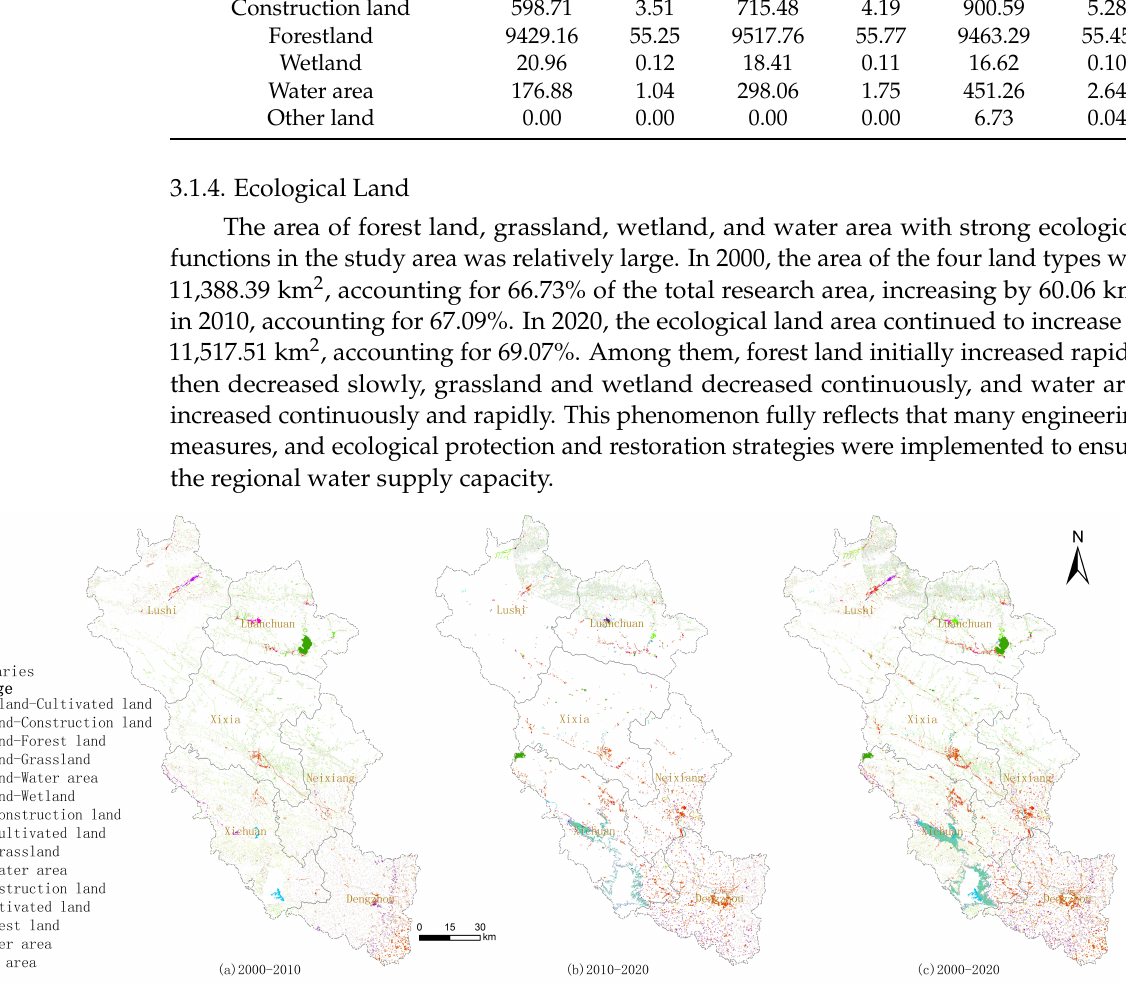
Figure 4. Spatial distribution of land use